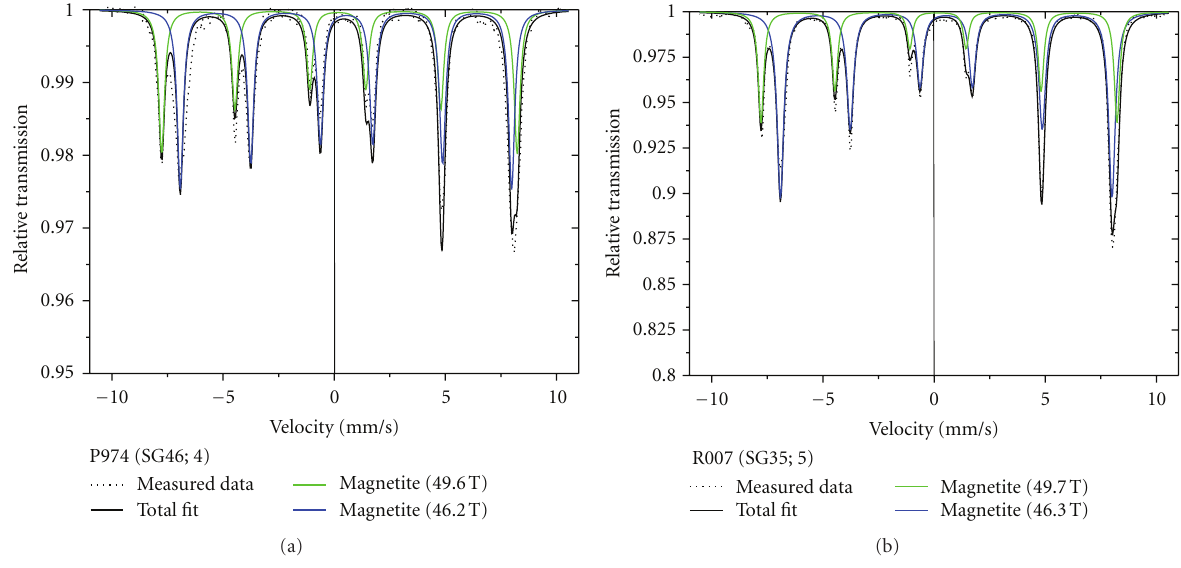
Outside (o), inside (i) (position, where the samples were taken), pipeline (pl), doublet presence (D), singlet (S), magnetite’s hyperfine magnetic field in Tesla (H 1A , H 1B ), ratio between A and B subcomponent areas in magnetite ( r AB ), hematite’s hyperfine magnetic field in Tesla (H 2 ), base material presence (B), area of the component in the spectra in % (A rel ).